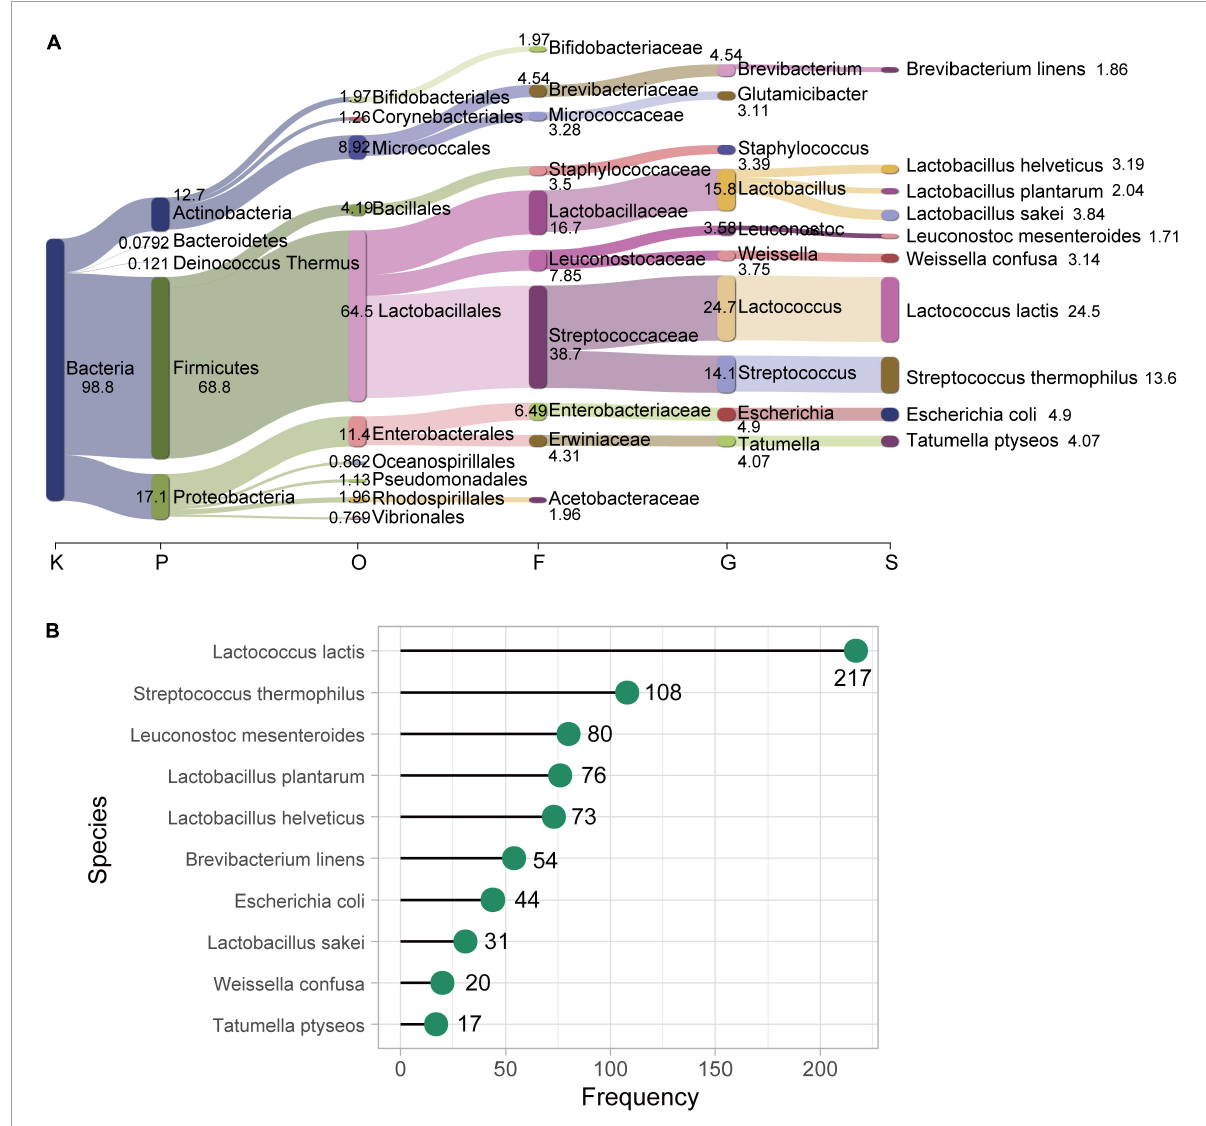
FIGURE1 Bacterial species in food metagenomes. (A) Taxonomic profile of food microbiome at different taxonomic levels. The top ten most abundant species at different taxonomic levels (Kingdom, Phylum, Order, Family, Genus, and Species) are displayed. The thickness of the flow (and the number beside the boxes) represents the average relative abundance (%) of each taxon, which is the average of relative abundance of all 323 food samples. Visualized with Pavian (Breitwieser and Salzberg, 2020). (B) The prevalence of the ten most abundant species in our food samples. The x-axis represents the frequency of positive samples for each species (y-axis) in the entire 323 food